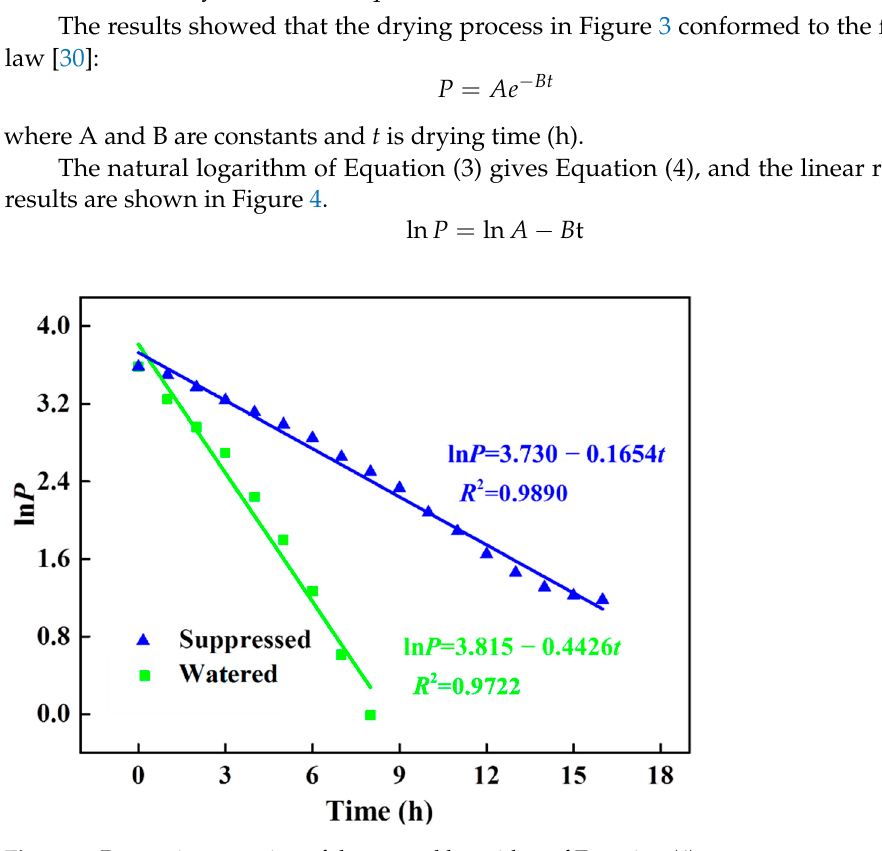
Figure 4. Regression equation of the natural logarithm of Equation (4).